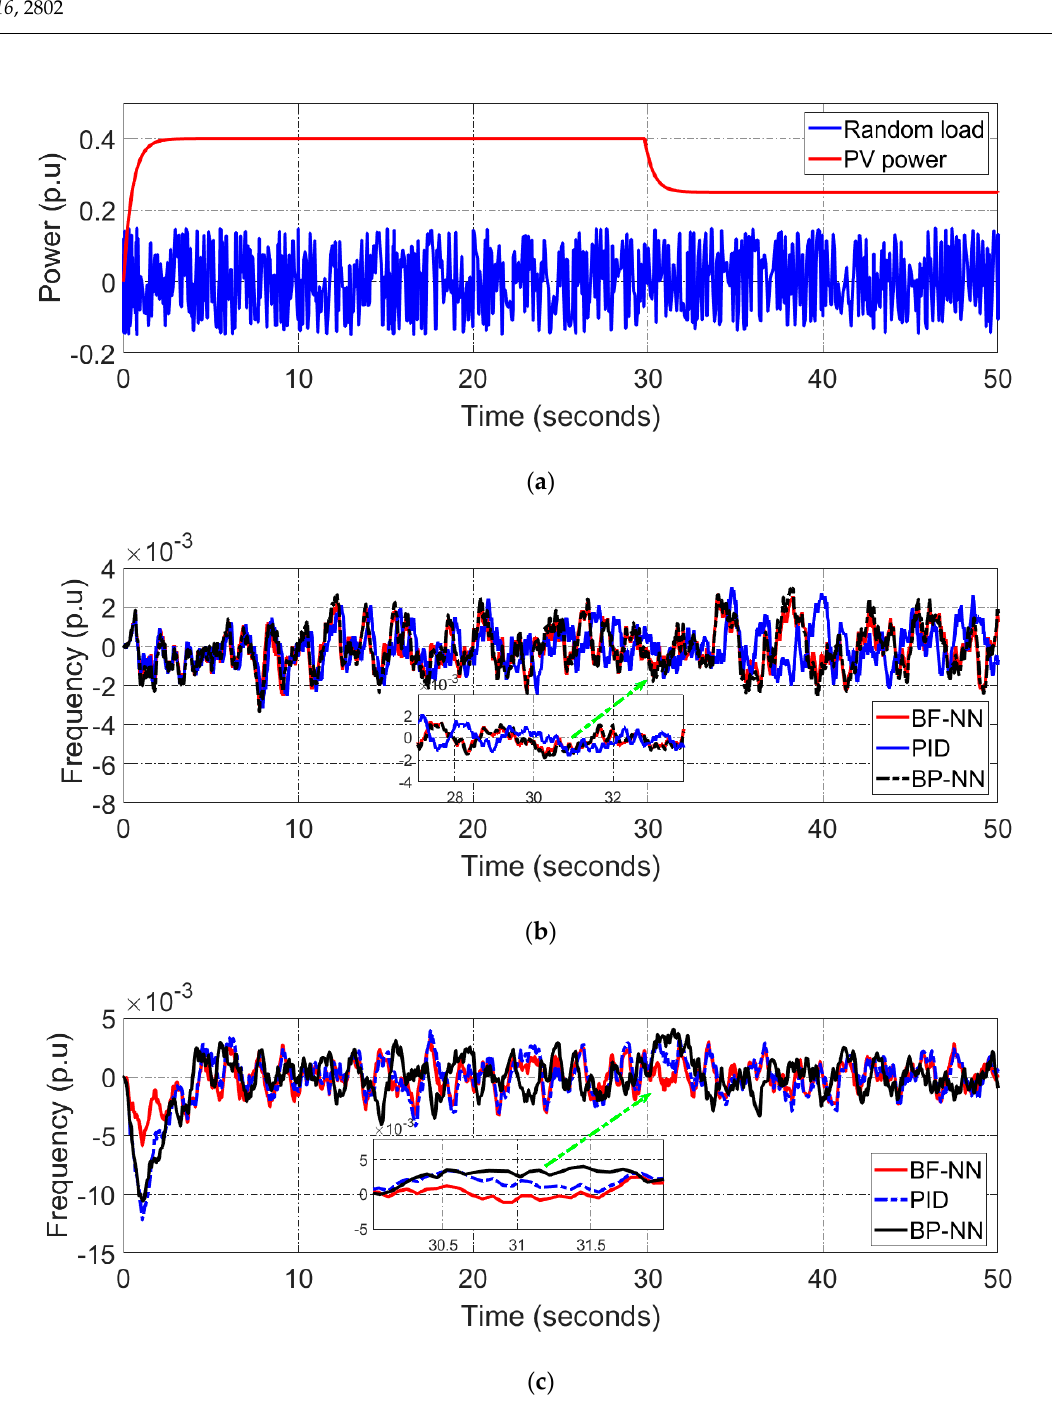
Figure 12. Division signals in a fault condition state of ( a ) input power, ( b ) output frequency without PV generation, and ( c ) output frequency with PV generation.